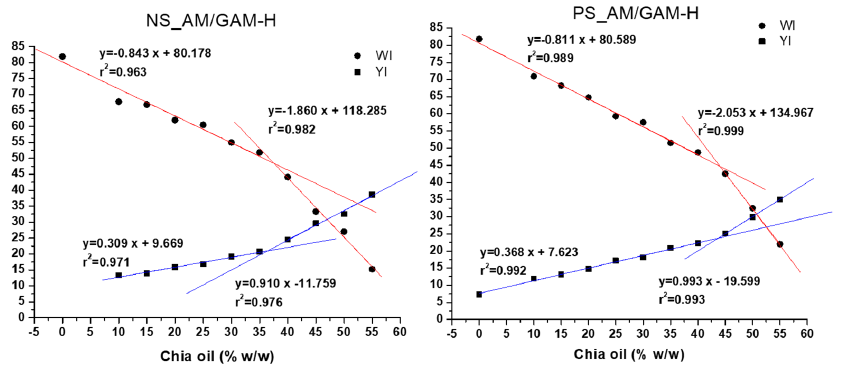
Figure 4. Trend analysis of colorimeter results of native starch (NS) and pretreated starch (PS) hydrolyzed with the mixture of α -amylase and glucoamylase with the highest dose (AM/GAM-H). WI: whiteness index; YI: yellowness index.